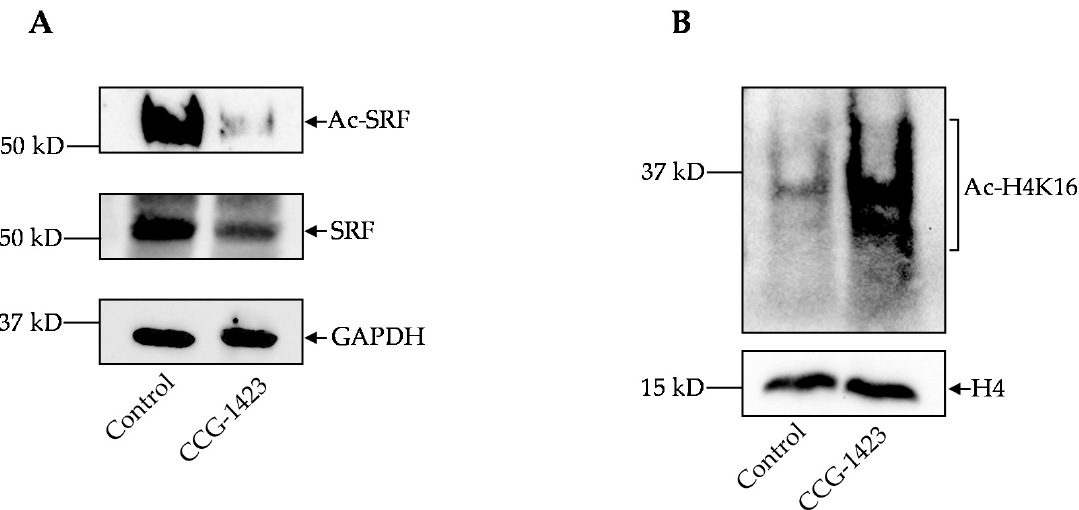
Figure 2. Immunoprecipitation of SRF acetylated lysine and H4K16 protein. ( A ) CCG-1423 represses the SRF acetylated-lysine (Ac-SRF), representative western blot of acetylated-lysine SRF and SRF in lysates from CCG-1423 treated and non-treated C2C12 cells. GAPDH was used as a loading control. ( B ) H4K16 was hyperacetylated on the CCG-1423 treatment, representative western blot image of H4K16 and total histone H4 protein was used as a loading control ( n = 3).